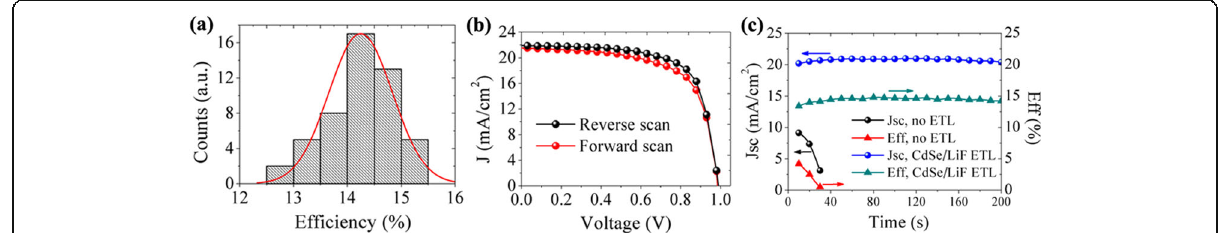
Fig. 4 Performance statistics of the solar cells ( a ), I - V curves of the forward and reverse-can mode of the best solar cell ( b ) and comparison of performance stability of the solar cells with and without ETL ( c